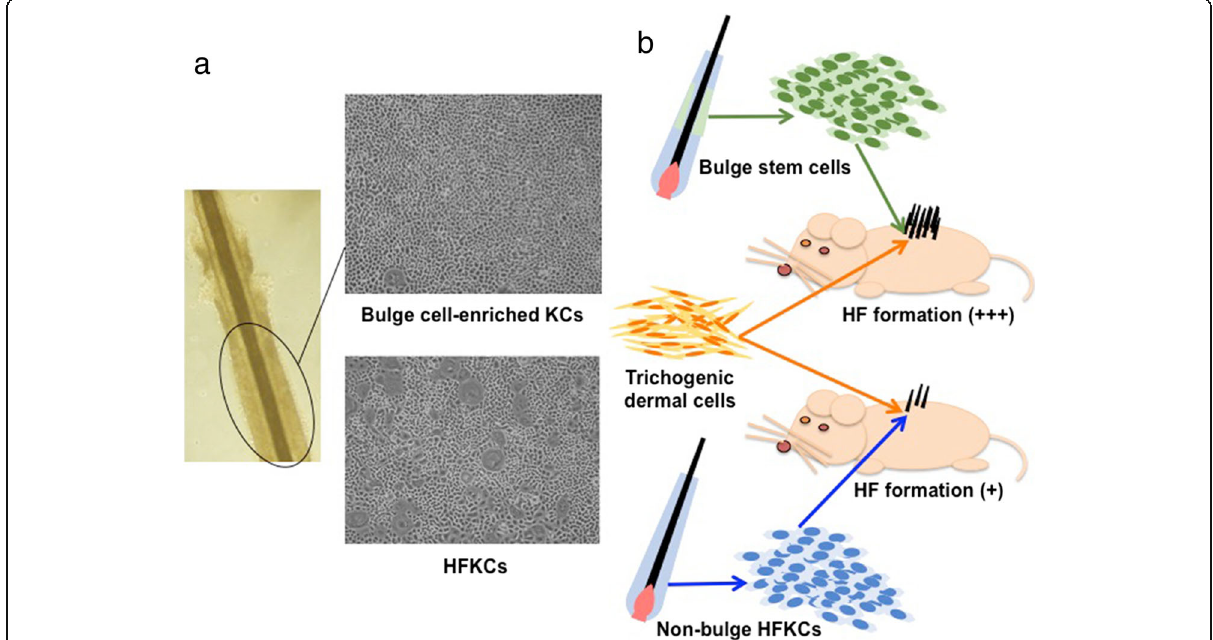
Fig. 5 Use of epithelial stem/progenitor cells to increase HF formation efficiency. a Isolated human HF bulge cell-enriched keratinocytes (KCs) are highly proliferative when compared to non-bulge HFKCs. b The comparison of hair forming capacity between bulge stem cells (SCs) and non- bulge HFKCs. The same number of bulge SCs and non-bulge HFKCs were isolated form HFs and co-transplanted with the same amount of trichogenic dermal cells (usually mouse neonatal dermal fibroblasts) into immunodeficient mice to assess HF forming